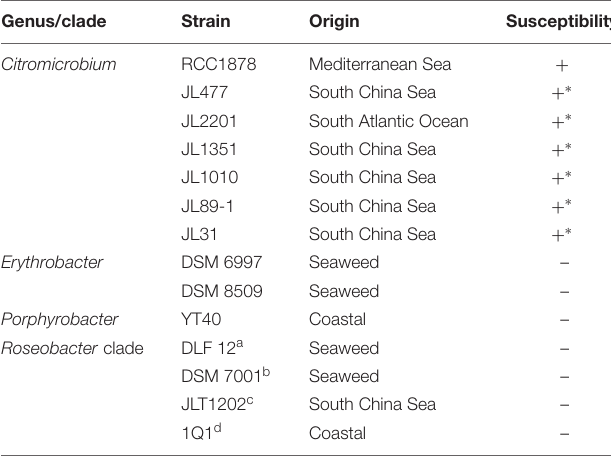
TABLE 2 | Bacterial susceptibility to phage vB_Cib_ssDNA_P1.